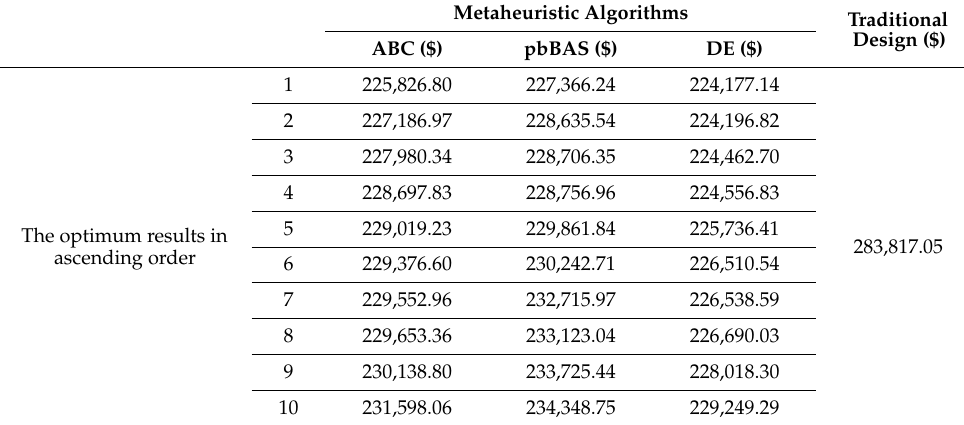
Table 14. Optimum results achieved in the V-type folded plate roof building by each metaheuristic